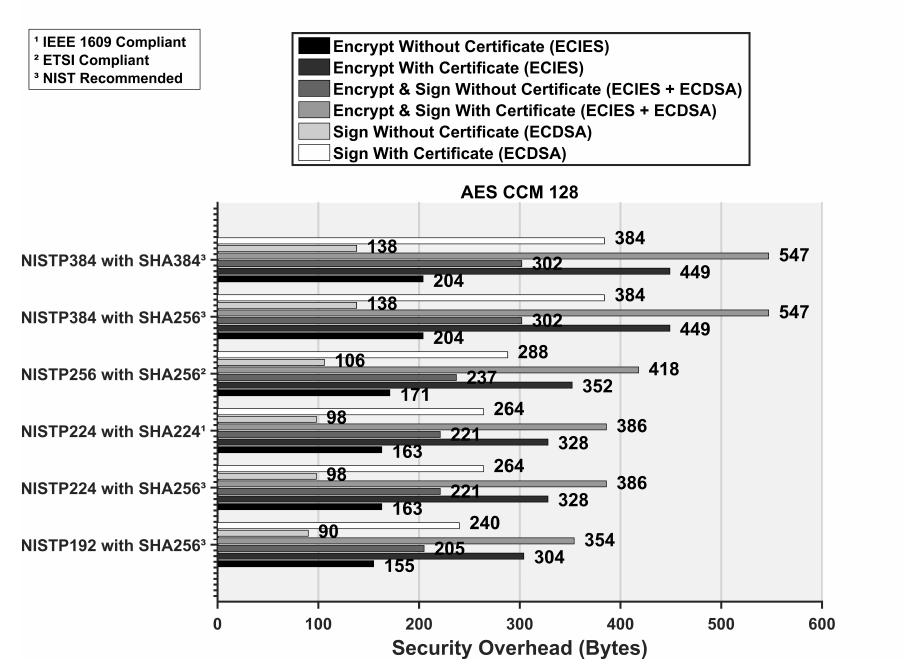
Figure 10. Security overhead required for different security procedures in conformance with the IEEE WAVE and the ETSI standard at AES CCM